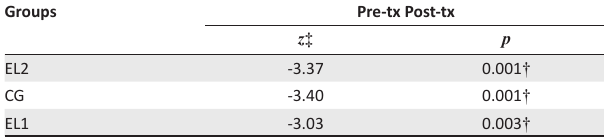
FIGURE 5: Average scaled pre- and post-intervention scores of all groups on the UCT Spelling TABLE 9: Results of t -tests for significant differences in pre- and post-intervention scores on spelling within groups.